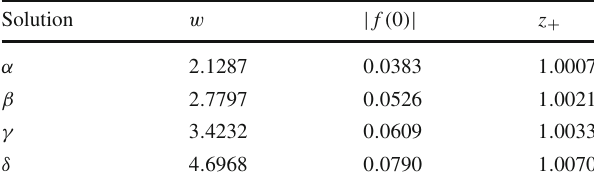
Table 2 Solutions for the elliptic class in six dimensions